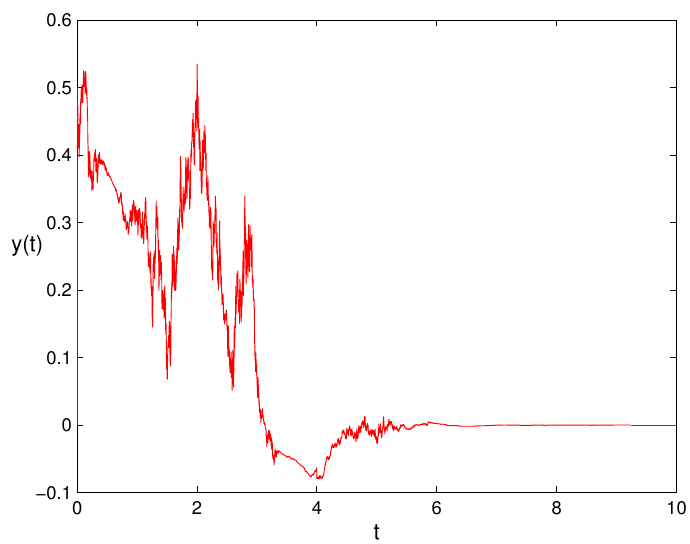
Figure 1. The trajectory of y ( t ) in system